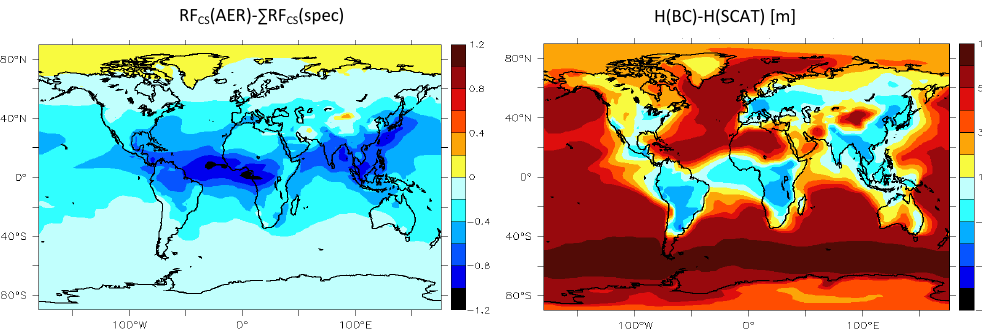
Fig. 8. Left: difference between the actual total aerosol forcing, RF CS (AER) [Wm − 2 ], and the sum of forcings per species, P RF CS (spec) [Wm − 2 ]. Right: characteristic height of BC AOD, H (BC) [m], minus characteristic height of the ensemble AOD of the other species, H (SCAT) [m]. The differences in heights are multiplied by the product of the 2-D optical depth of BC and of the ensemble AOD of the other